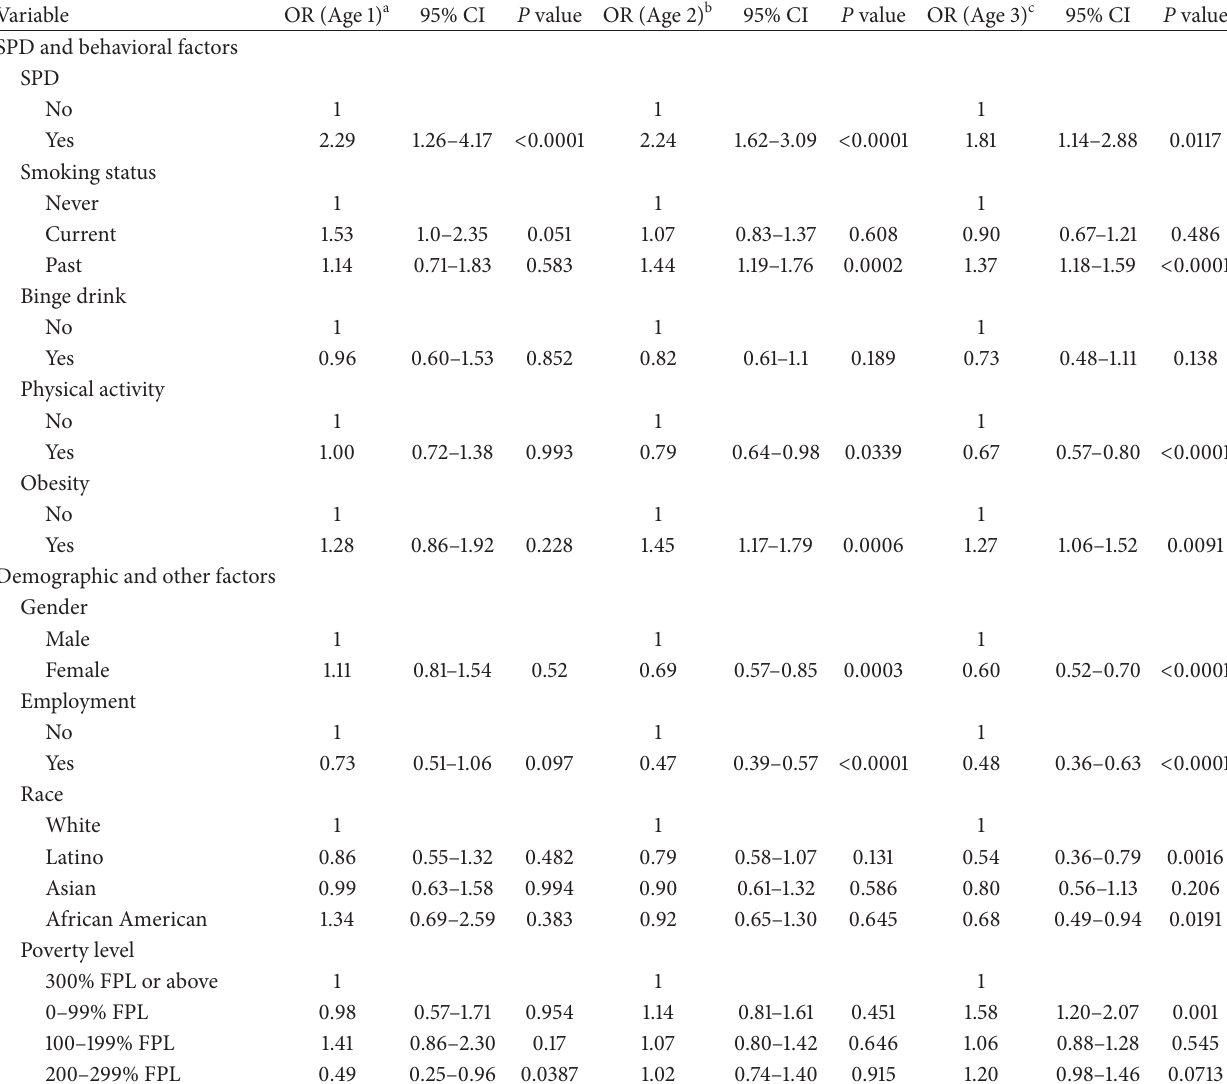
Table 3: Age differences in risk factors for heart disease using multiple logistic regression